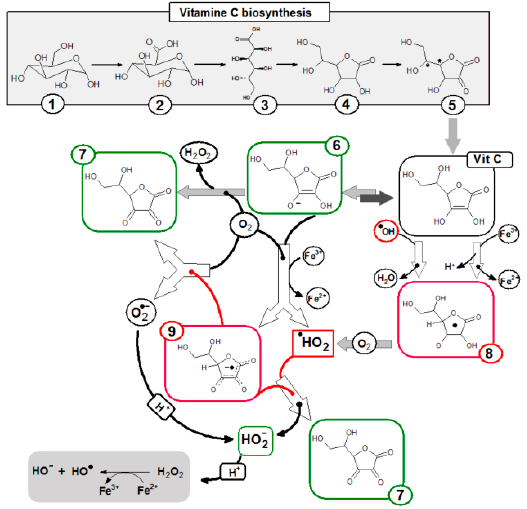
Figure 1. Pathway of ascorbic acid synthesis in animals (except humans, primates, and guinea pigs) and chemical transformation pathway of ascorbic acid. ( 1 ) α - D -glucopyranose; ( 2 ) D -glucuronic acid; ( 3 ) Gulonic acid; ( 4 ) L -gulonolactone; ( 5 ) 2-keto- L -gulonolactone; ( 6 ) Ascorbate anion; ( 7 ) Dehydroascorbic acid; ( 8 ) Ascorbyl radical; ( 9 ) Ascorbyl radical anion.